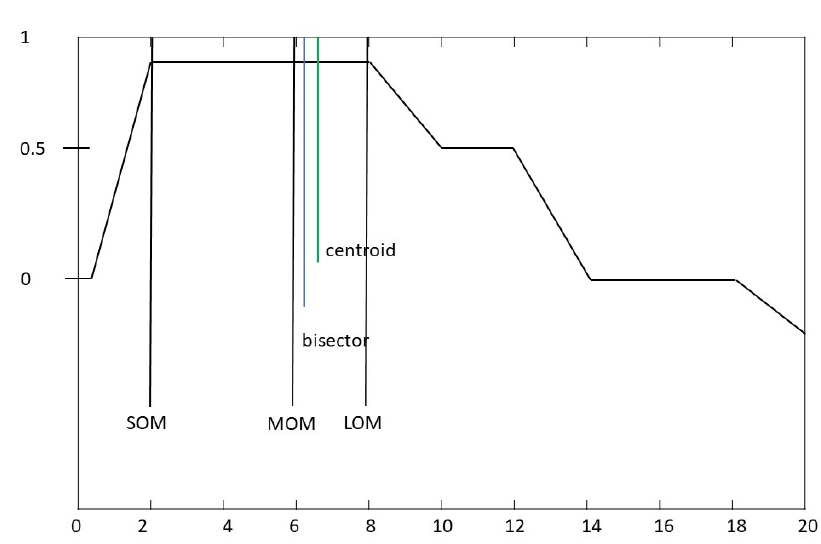
Figure 8. Visualisation of Bisector Defuzzification.